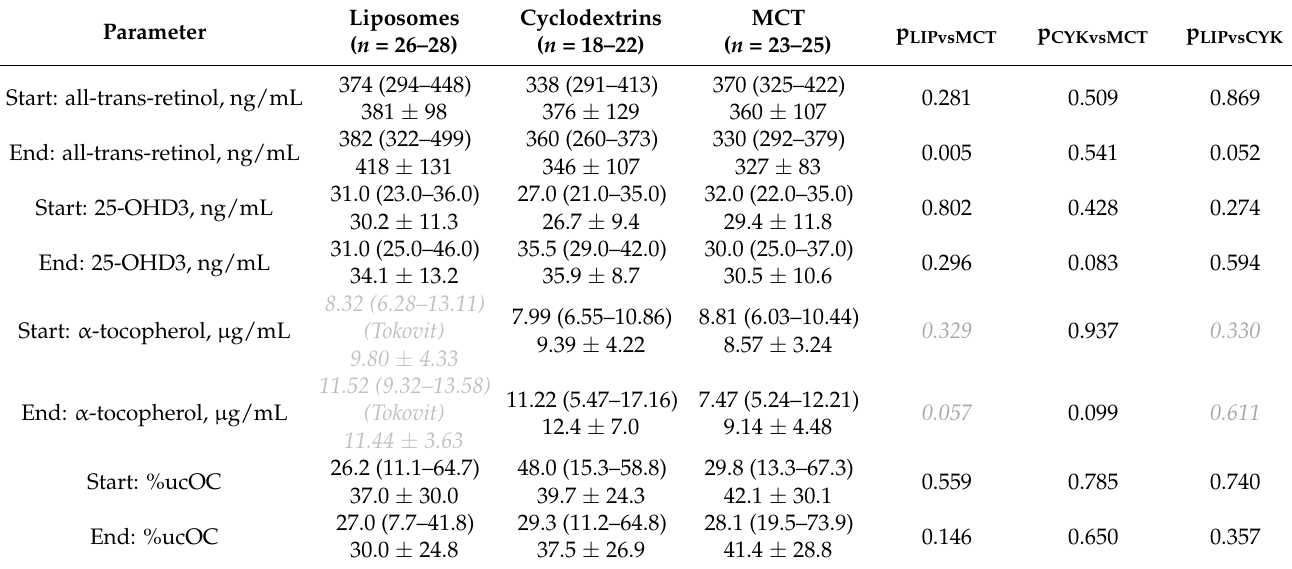
Table 4. Vitamin A, D, E, and K status (serum) in CF patients before and after supplementation. Medians (1st–3rd quartile) are given along with means ± standard deviation. Statistical significance for the increase/decrease is given in Figure 2. Statistical significance (two-sided p -value) for direct comparisons of values using the Welch test is